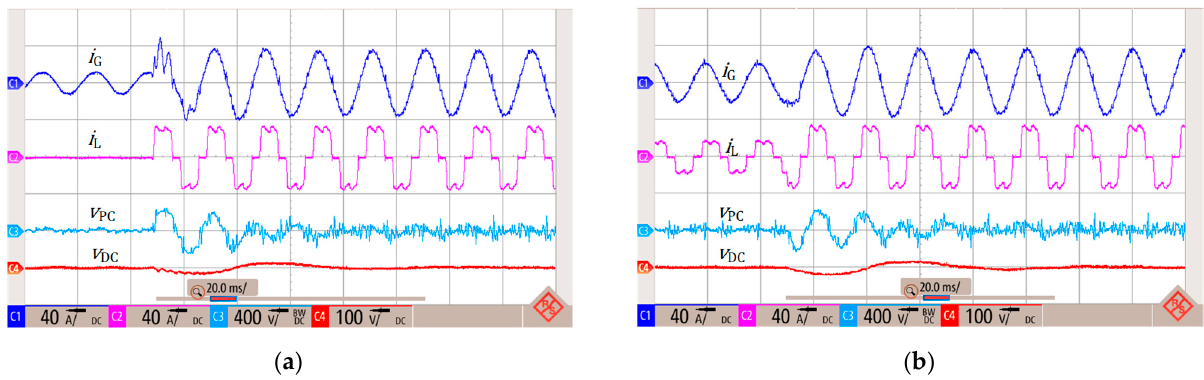
Figure 21. Example waveforms for the HAPF dynamic states ( a ) start the load Ld1 ( b ) power change of load Ld1.